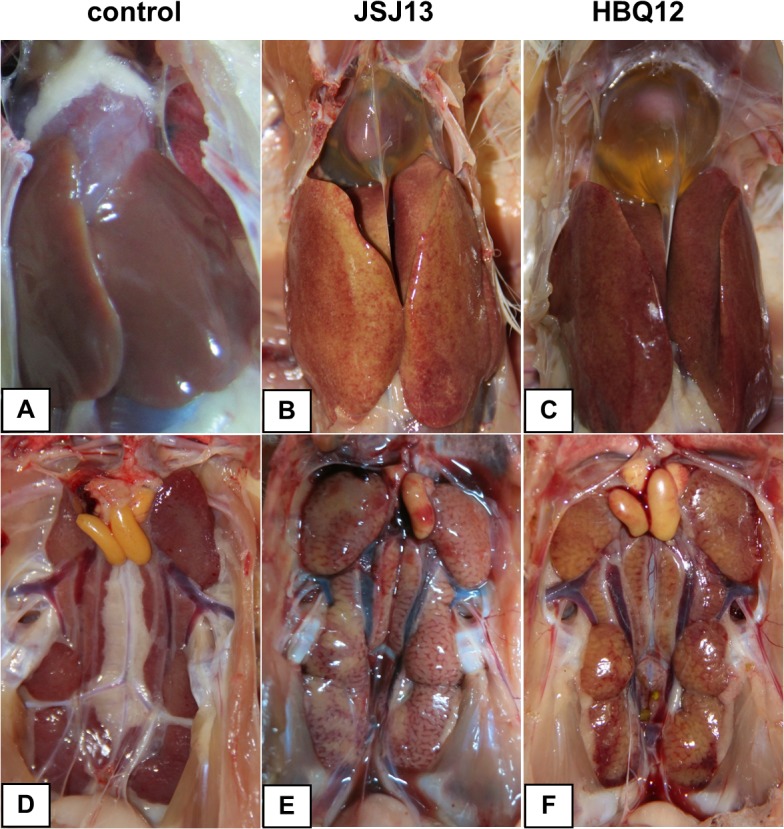
Gross lesions in liver, heart, and kidney from dead chickens at 6 dpi.(B&C) Swollen and friable liver with multifocal areas of necrosis and petechial haemorrhage and hydropericardium. (E&F) Mild or severe enlargement in the kidney of the infected chickens.